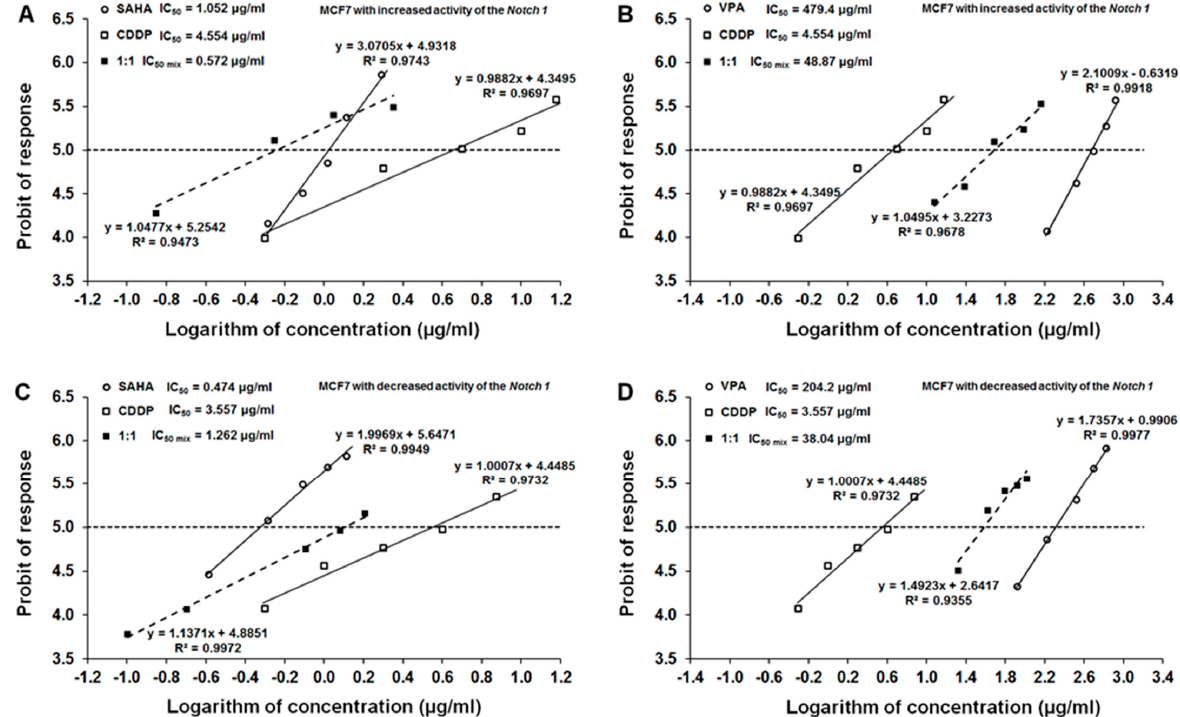
Figure 2. Log-probit dose-response relationship lines for CDDP, SAHA, and VPA in transfected MCF7 cells. ( A ) Log-probit dose-response relationship lines for CDDP and SAHA administered alone and in combination at the fixed-ratio of 1:1, with respect to their anti-proliferative effects on MCF7 cells with increased activity of Notch1 (Notch1 high MCF7); ( B ) log-probit dose-response relationship lines for CDDP and VPA administered alone and in combination at the fixed-ratio of 1:1, with respect to their anti-proliferative effects on Notch1 high MCF7cells; ( C ) log-probit dose-response relationship lines for CDDP and SAHA administered alone and in combination at the fixed-ratio of 1:1, with respect to their anti-proliferative effects on MCF7 cells with decreased activity of Notch1 (Notch1 low MCF7); ( D ) log-probit dose-response relationship lines for CDDP and VPA administered alone and in combination at the fixed-ratio of 1:1, with respect to their anti-proliferative effects on MCF7 cancer cells with decreased activity of Notch1 (Notch1 low MCF7). Doses of particular compounds (CDDP, SAHA, and VPA) administered both separately and in combination were transformed into logarithms, whereas the anti-proliferative effects produced by the drugs in the cancer cell line MCF7 were transformed into probits according to Tallarida method [25]. Equations of dose-response relationship lines are presented on the multipart figure. Respective IC 50 values are depicted in the left corners of each panel.